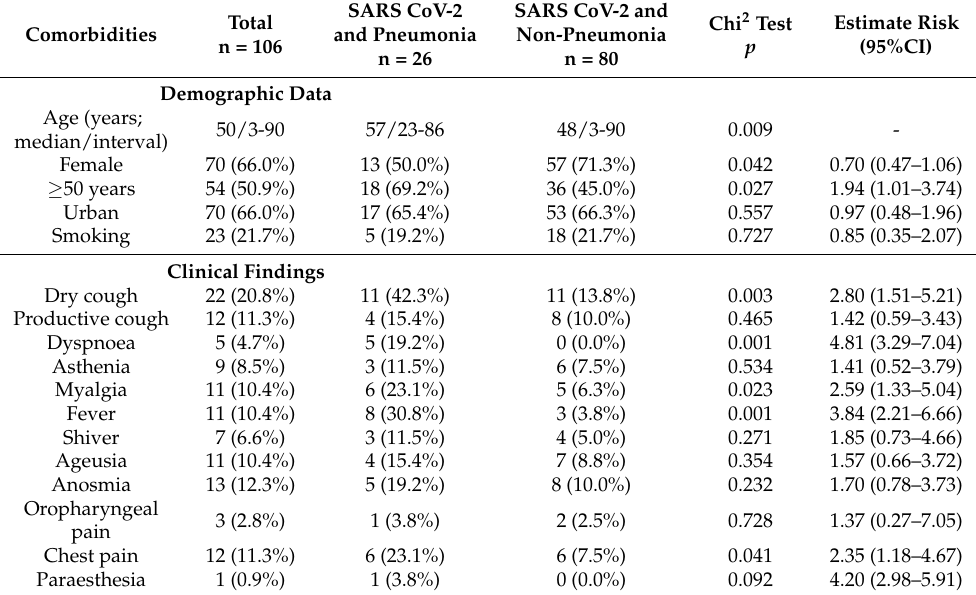
Table 1. Descriptive statistics of demographical data, signs, and symptoms of the patients included in the study. Comorbidities